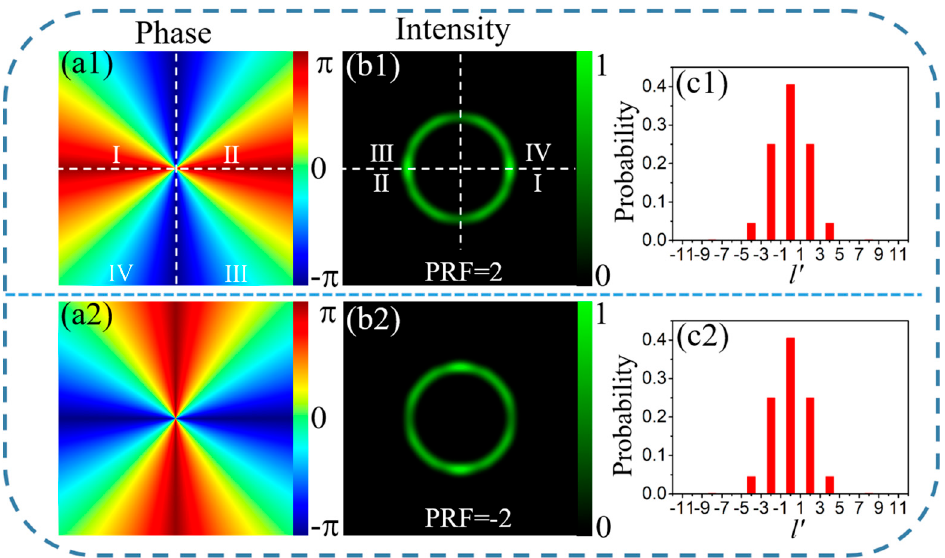
Figure 1. Schematic of the centrosymmetric optical vortex (CSOV) generation. ( a1 ) and ( a2 ) are spiral phase patterns, ( b1 ) and ( b2 ) are intensity patterns, and ( c1 ) and ( c2 ) are decompositions of the orbital angular momentum (OAM) states, where l’ ∈ (- ∞ , ∞ ) is an integer reflected the single states.